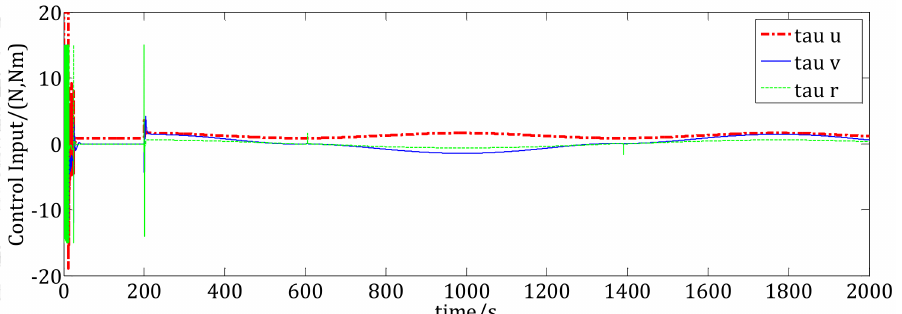
Figure 12. Control inputs of the USV under the NTTC